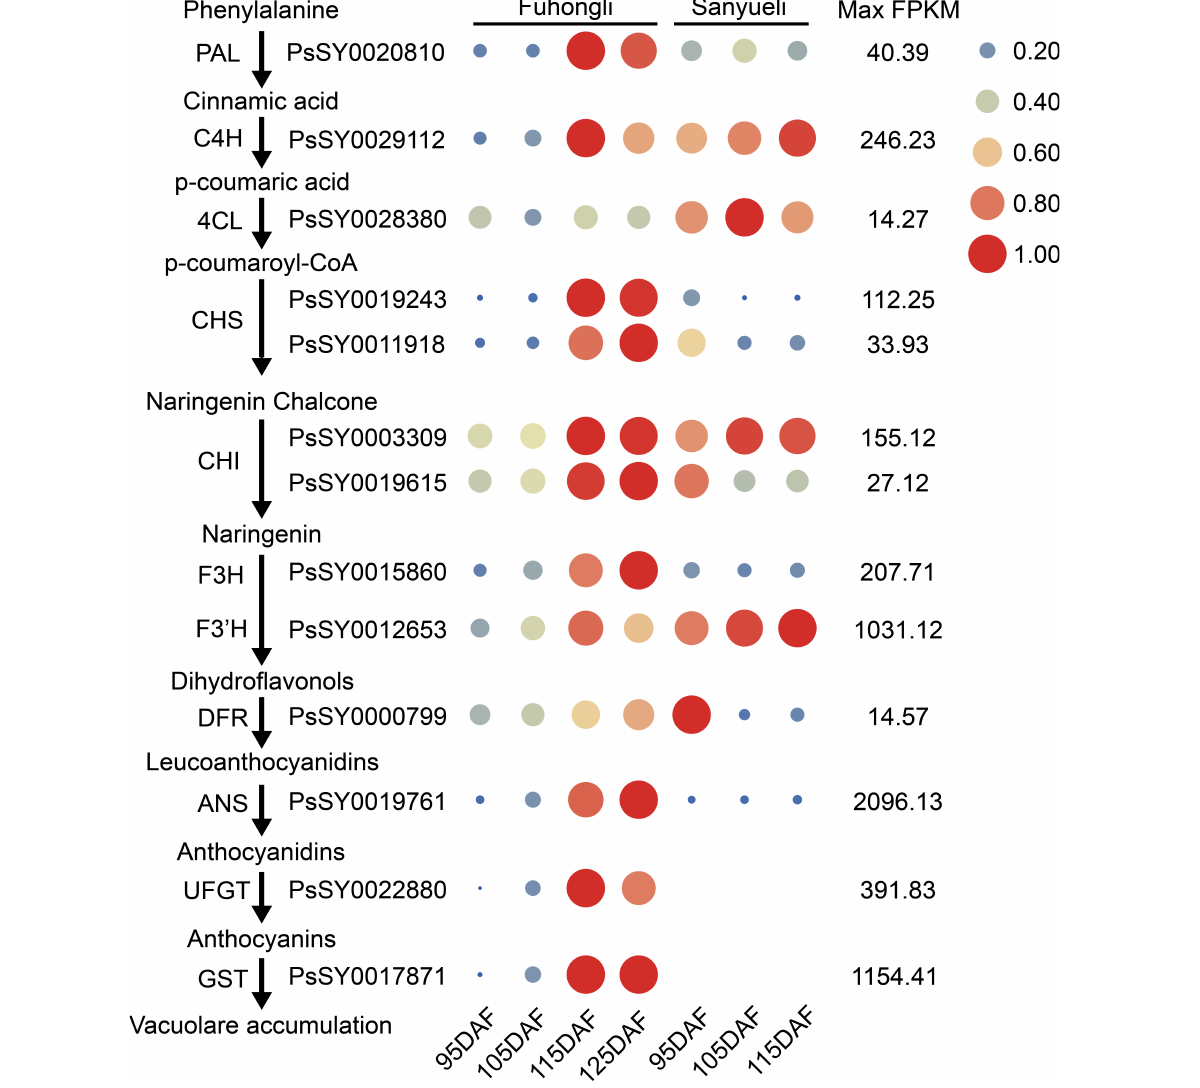
FIGURE 3 | Expression of structural genes involved in the phenylpropanoid and anthocyanin biosynthesis, as evaluated by RNA-sequencing in the plum flesh of ‘Sanyueli’ and ‘Fuhongli’. FPKM values of all genes were normalized with maximum FPKM values of each gene. The expression level of genes was indicated using filled circle with different size and color. The larger the circle, the higher the expression. High expression was indicated in red, while low expression was indicated in blue. The values on the right indicates the highest FPKM value of each gene. Abbreviations for pathway genes as described in the